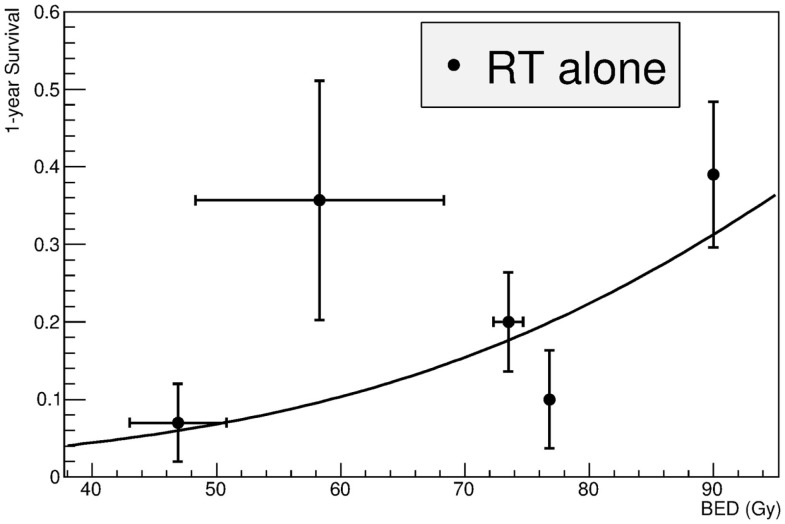
Fit of the clinical data for treatment of LAUPC with X-ray radiotherapy alone. Studies are listed in Table 1. BED is calculated by Eq. 4. Fitting was performed by Eq. 2 and fitting parameters are in Table 3.